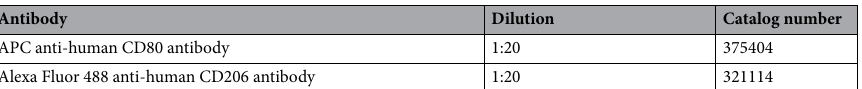
Antibody Dilution Catalog